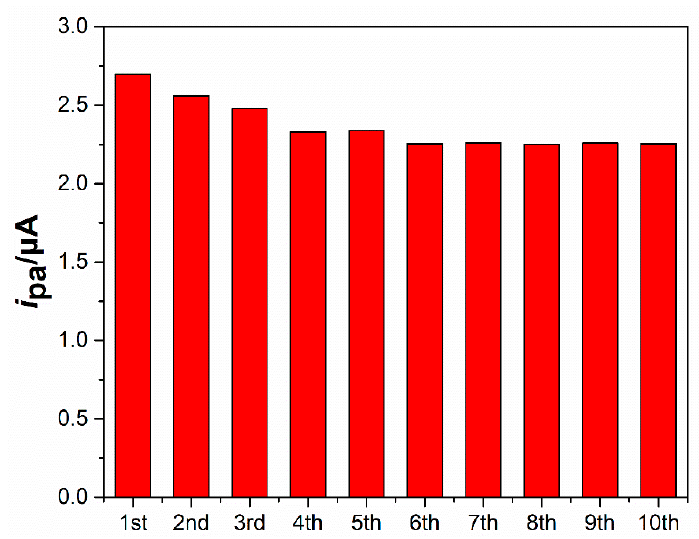
Figure 9. Response anodic peak currents of 10 µ M Trp for ten successive measurements ( n = 10).